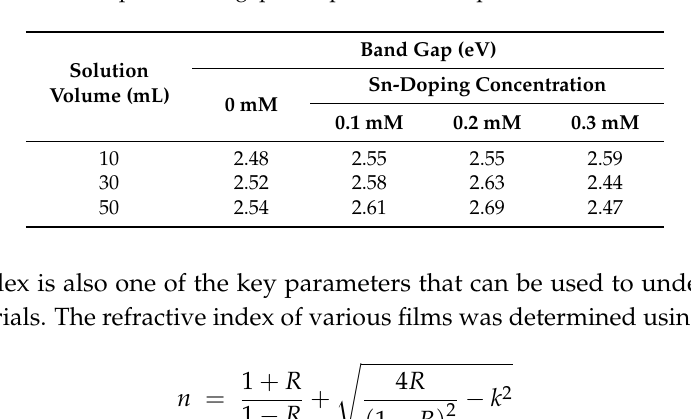
Table 4. Refractive index values of doped and un-doped CdO films prepared using 30 mL solution.